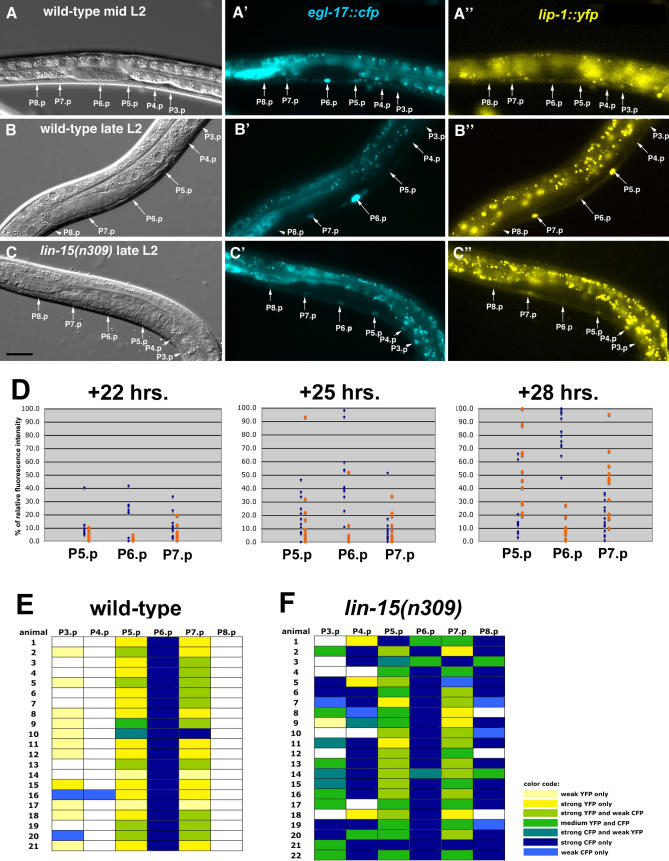
Experimental Validation of the Model's Predictions(A,B) As examples for the time-course analysis, a mid-L2 larva at +22 h (A–A″) and a late L2 larva at +28 h (B) are shown. For each animal, the Nomarski, CFP (‘), and YFP (‘') channels are shown.(C–C″) Example of a lin-15(n309) larva at the late L2 stage showing simultaneous expression of EGL-17::CFP and LIP-1::YFP in P7.p, P5.p, and P4.p. All images were taken with identical camera and microscope settings. Scale bar in C is 10 μm.(D) Quantification of the EGL-17::CFP (blue dots) and LIP-1::YFP (orange dots) signals in P5.p, P6.p, and P7.p of ten to 12 animals for each time point. The relative fluorescence intensities are shown as percent values of the maximal EGL-17::CFP and LIP-1::YFP signals, respectively, observed during the time-course analysis.(E,F) Semiquantitative representation of the EGL-17::CFP and LIP-1::YFP expression patterns observed in the VPCs of wild-type (E) and lin-15(n309) (F) late L2 larvae. Signal intensities were classified as indicated by the color legend on the right.